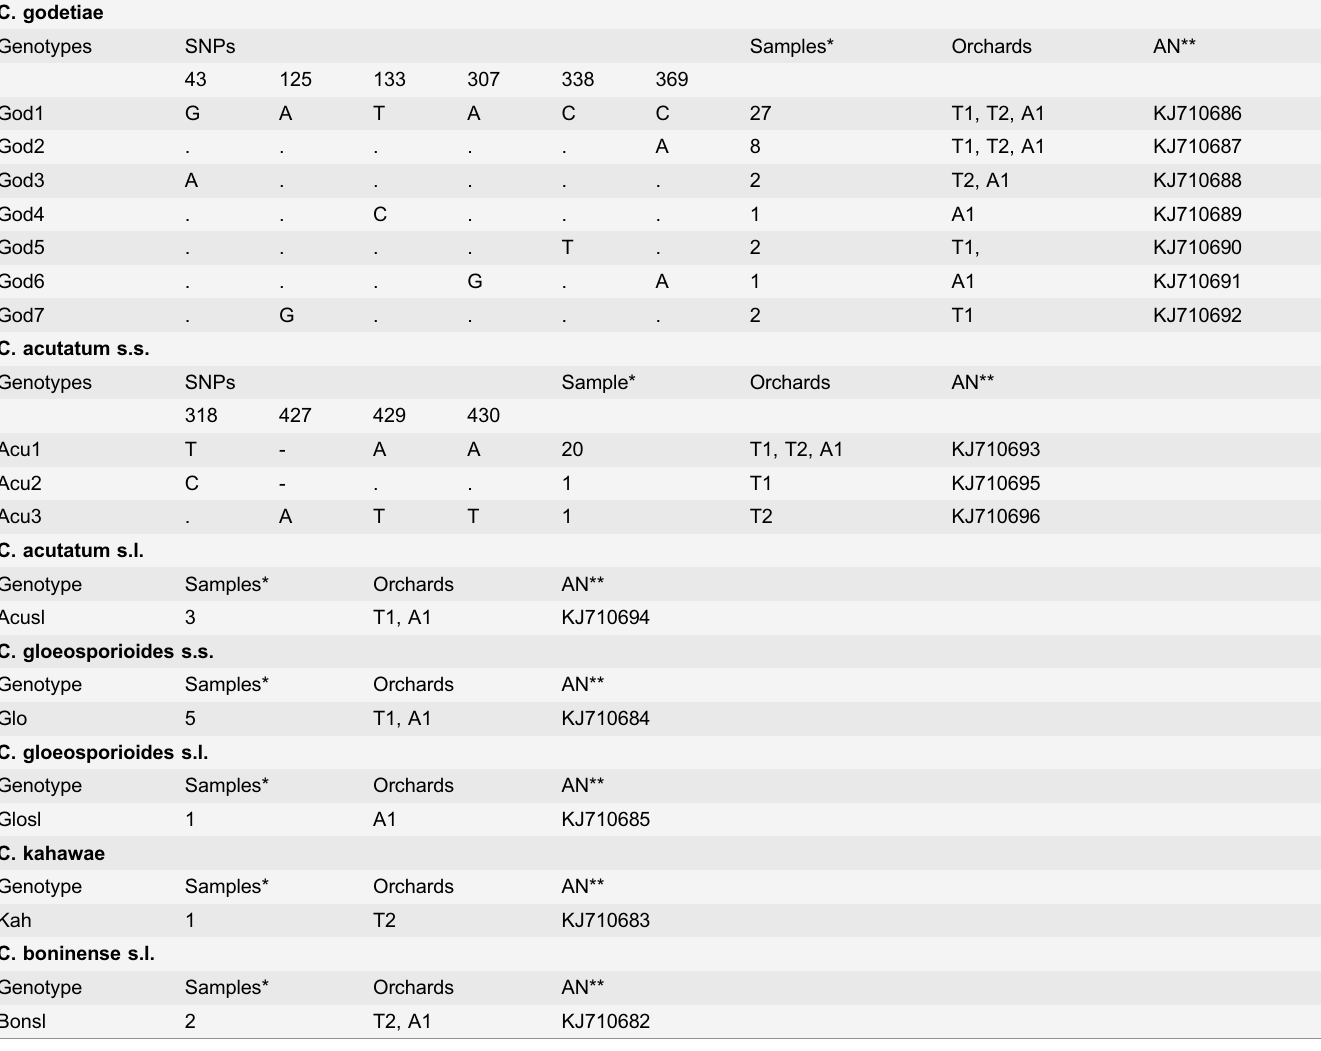
Table 3. List of Colletotrichum species and ITS genotypes identified in different olive tissues collected in three olive orchards on the Gioia Tauro plain (southern Italy). C.